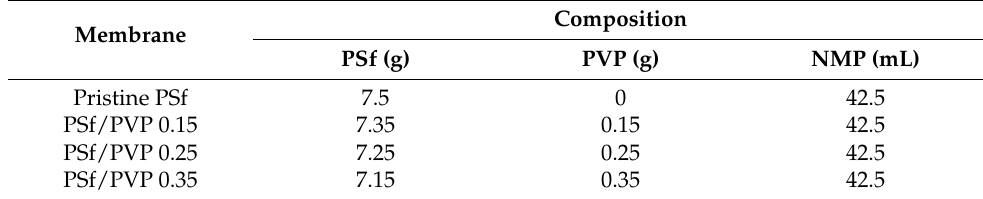
Table 2. Membrane composition.